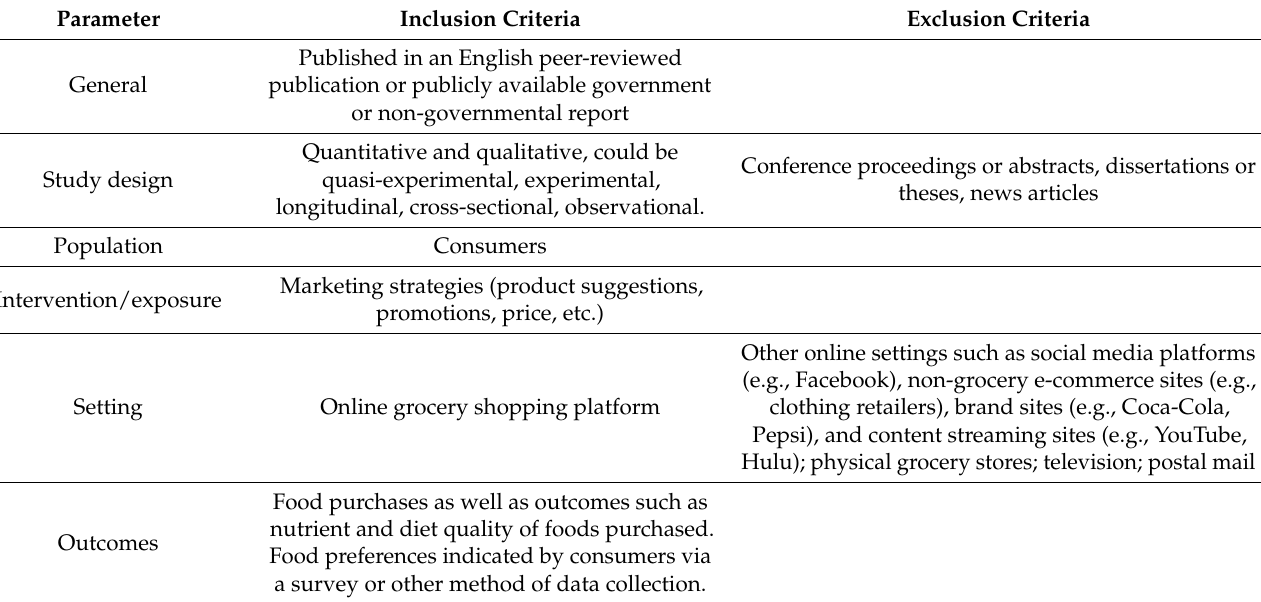
Table 1. PI(E)COS criteria for inclusion and exclusion of